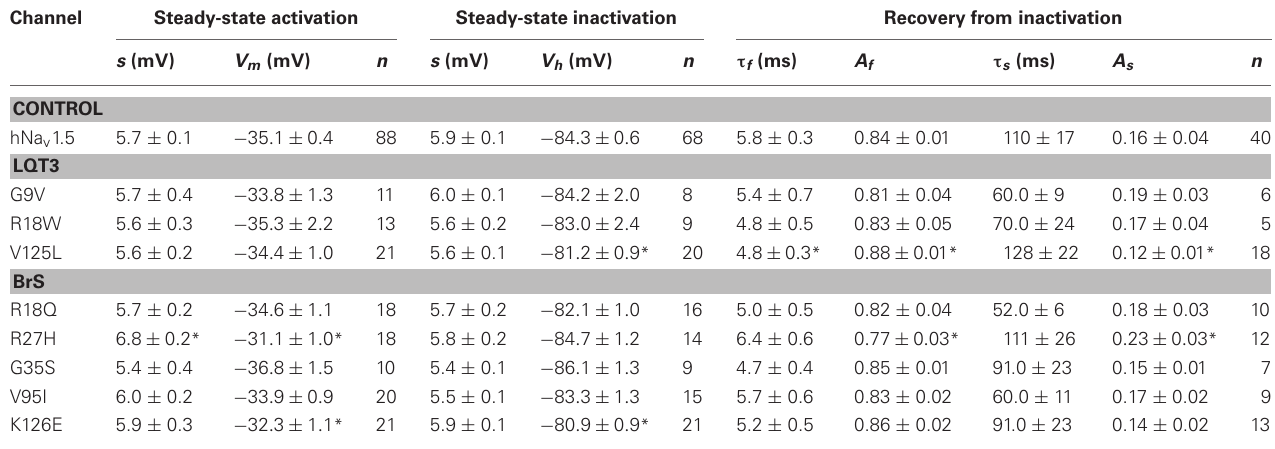
* indicates p < 0.05 vs. hNa v